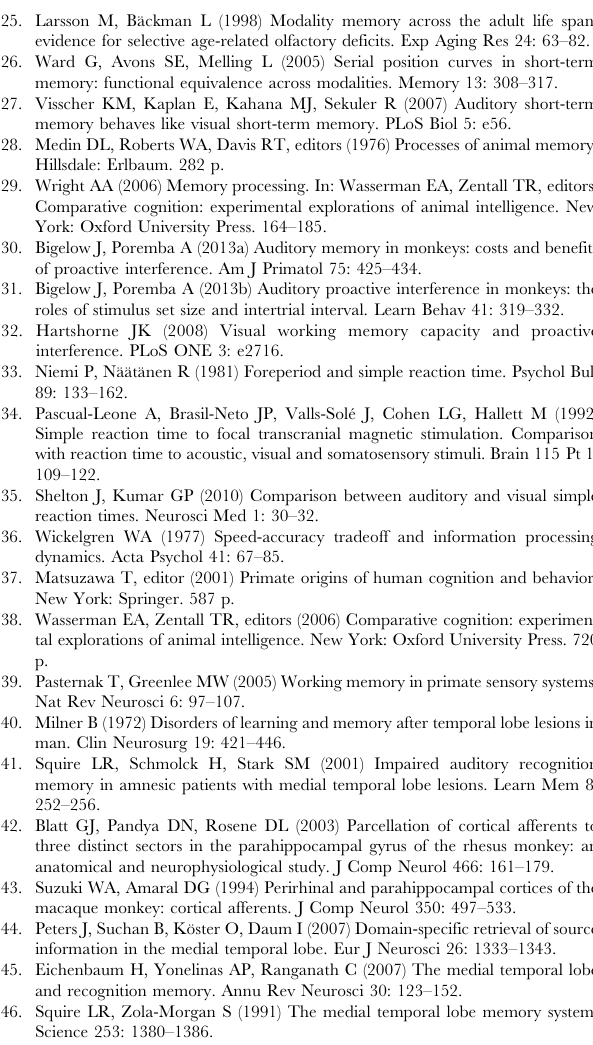
Figure S2 Experiment 2: Mean ( + SEM) recognition response latency among sensory modalities for com- plex, naturalistic stimuli. Significant differences in response latency were not observed among sensory modalities for the (A) same-day, (B) next-day, or (C) next-week recognition delays. Although the data trended toward increased response latencies for the longer delays (and lower accuracy values), there was neither a significant effect of delay nor a significant interaction between sensory modality and delay. Table S1 List of stimuli used in Experiment 2. Auditory stimuli (left two columns) comprised 5-s sound recordings